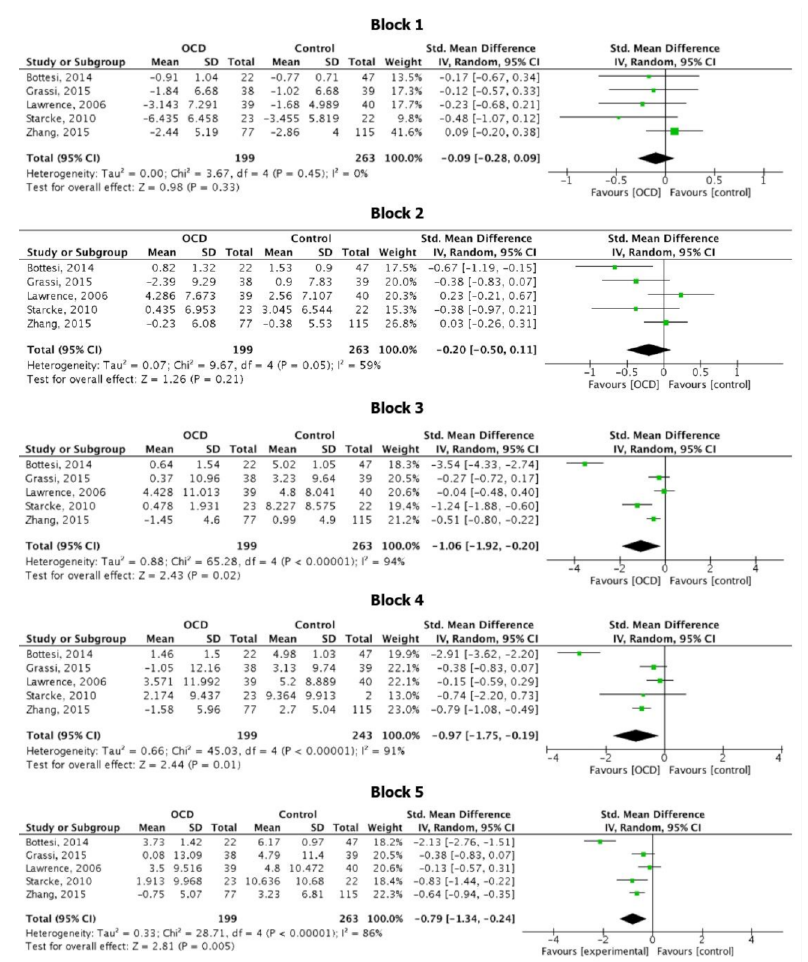
Figure 7. Forest plot relative to the IGT score at each